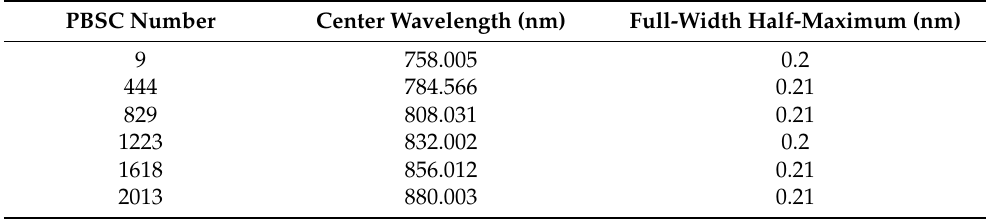
Table 6. Spectral calibration results of water vapor absorption band with observation channel (channel 5).